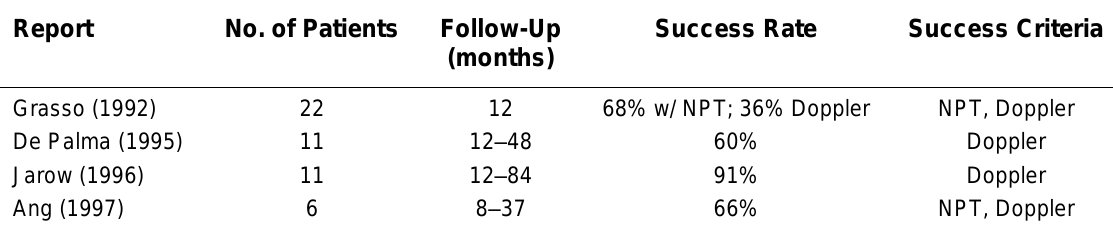
Prior Published Reports on Outcomes of Penile Revascularization that Met the Criteria for